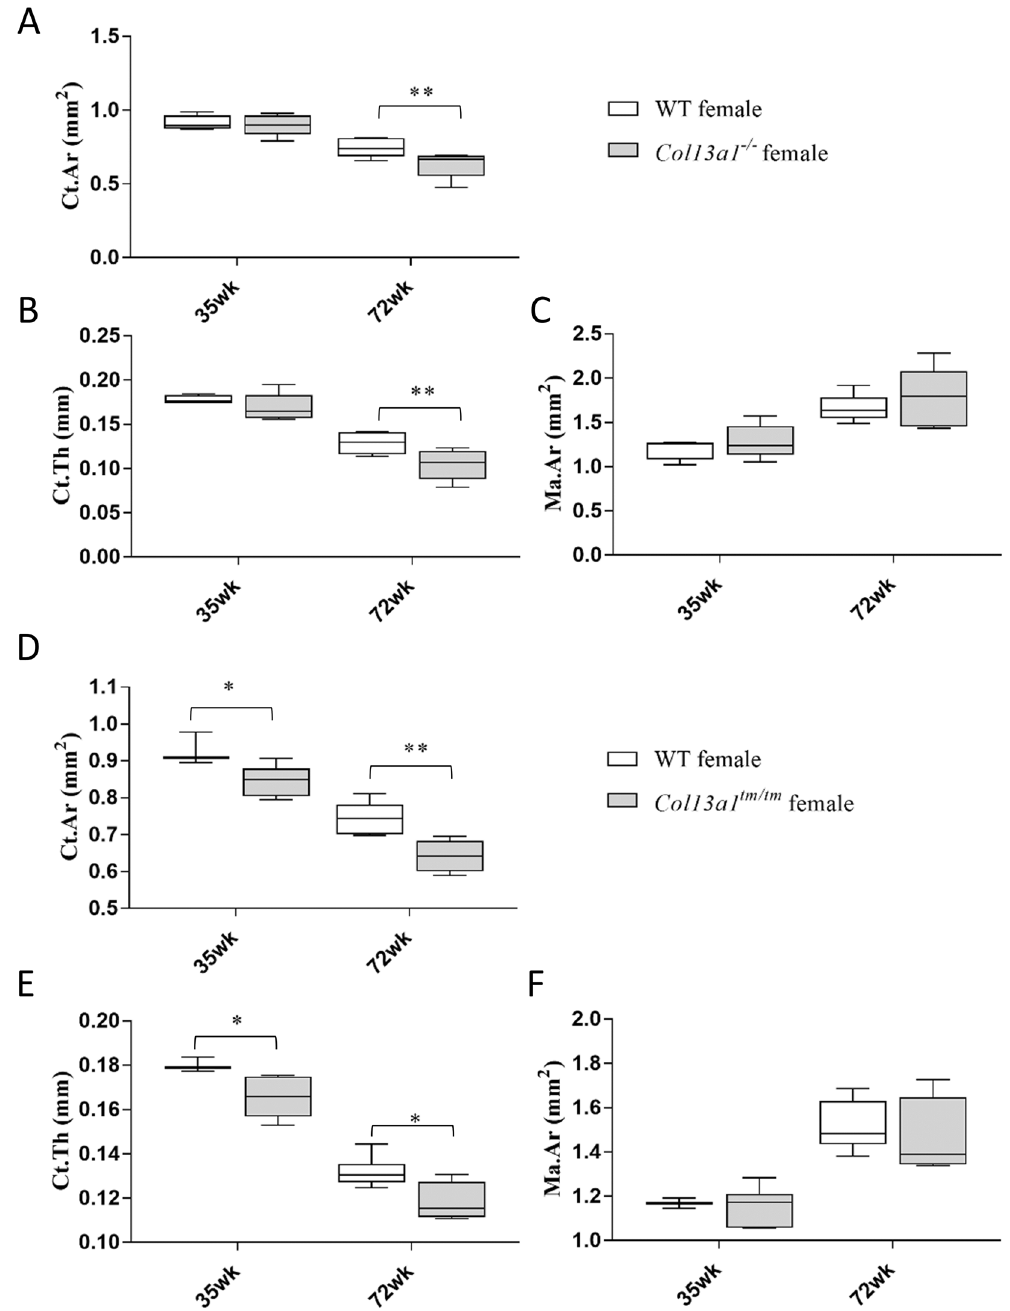
Figure 6. Morphometric parameters for HRCT analysis of metaphyseal cortical bone. The Col13a1 −/− female mice and respective WT controls ( A – C ). There were no statistically significant differences in the cortical area (Ct.Ar, A ) or thickness (Ct.Th, B ) or the medullary area (Ma.Ar, C ) at the 35-week time point. At the 72-week time point, Ct.Ar and Ct.Th were significantly reduced in the Col13a1 −/− samples compared to the WT mice. The Col13a1 tm/tm female mice and respective WT controls ( D – F ). The cortical area (Ct.Ar, D ) and thickness (Ct. Th, E ) were significantly reduced in the Col13a1 tm/tm mice at the 35- and 72-week time points compared to the respective controls. The medullary area (Ma.Ar, F ) was unaltered. n(WT female): 4–5; n( Col13a1 −/− female): 5; n(WT female): 3–6; n( Col13a1 tm/tm female): 4–6; the whiskers represent min to max; **q < 0.01 determined by two-way ANOVA and followed by the false discovery